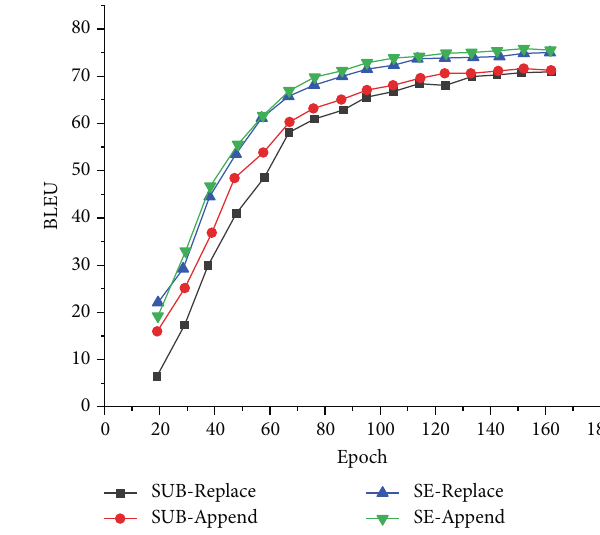
Figure 6: Epoch-BLEU change chart